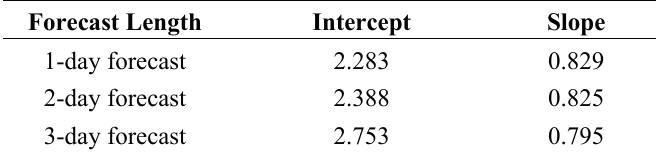
Table 1. Estimated coefficients when observed temperatures are used to model forecast